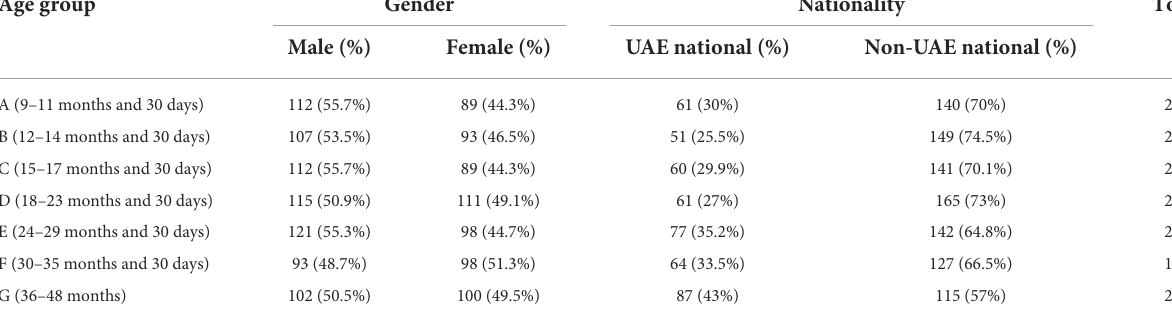
TABLE 2 Demographic information of infants and children who participated in the